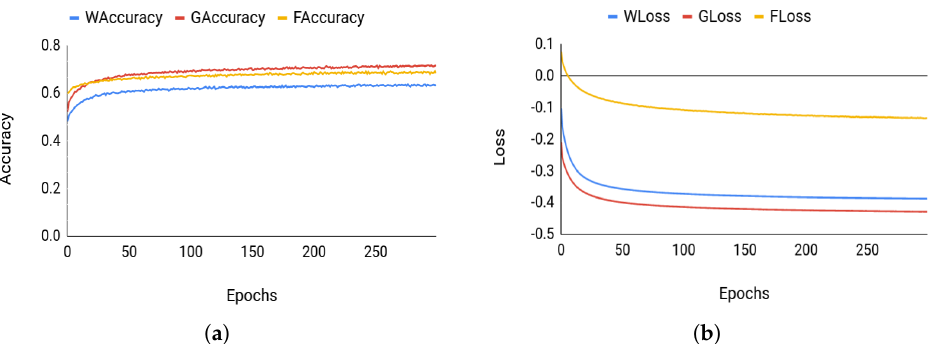
Figure 8. Graphical representation of Training Accuracy/Loss vs. Epochs for 1D-CNN model of TFGE. ( a ) Training Accuracy vs. Epochs; ( b ) Training Loss vs.